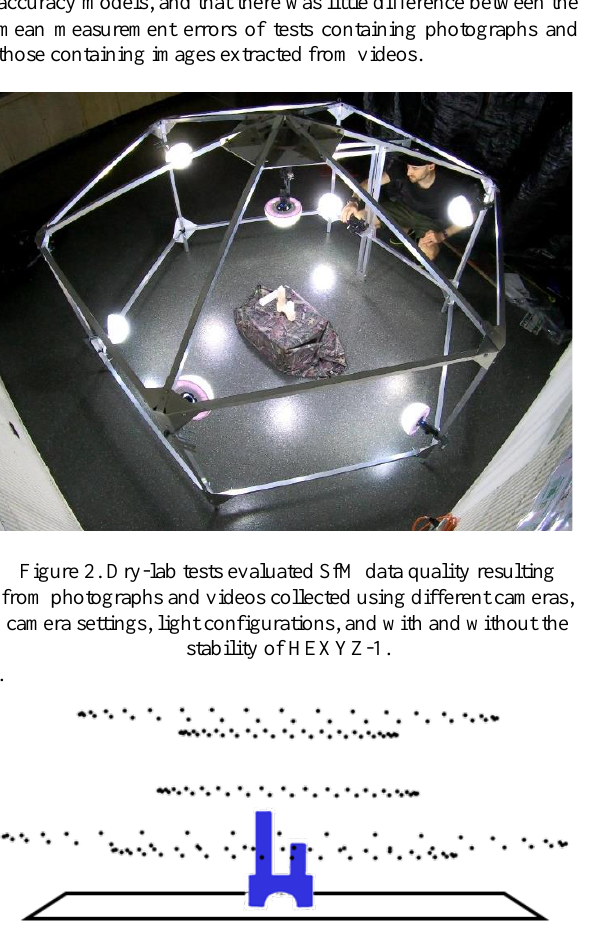
Figure 3. 180 images provided 360-degree coverage of the test subject. Images were captured from camera positions (black points) arranged in five halos around target objects (blue). This image shows a side perspective of the five halos of camera positions and target